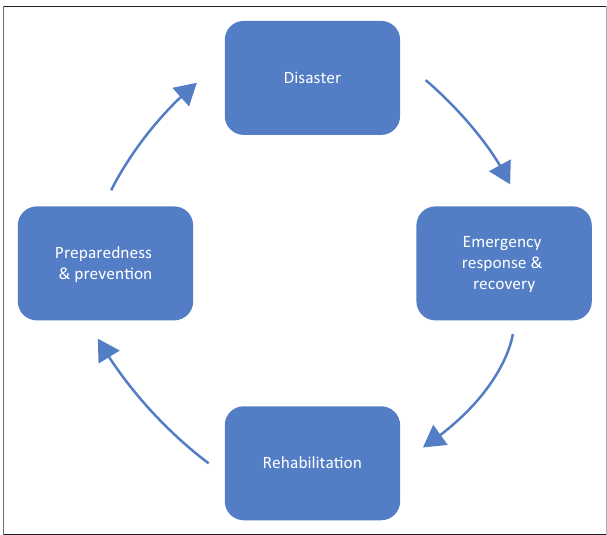
FIGURE 1: Cycle of